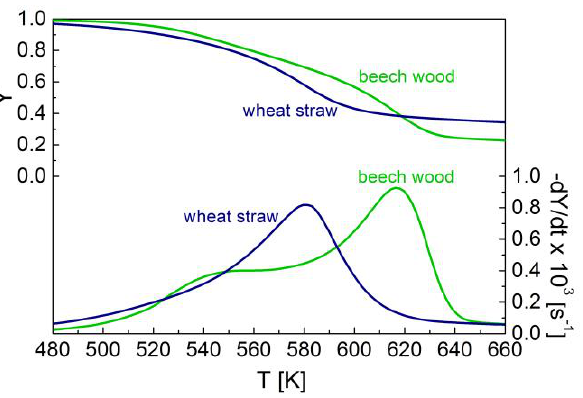
Figure 1. Mass fraction, Y, and mass loss rate − dY/dt for wheat straw and beech wood [22] versus temperature (heating rate 5 K/min, up to 773 K).